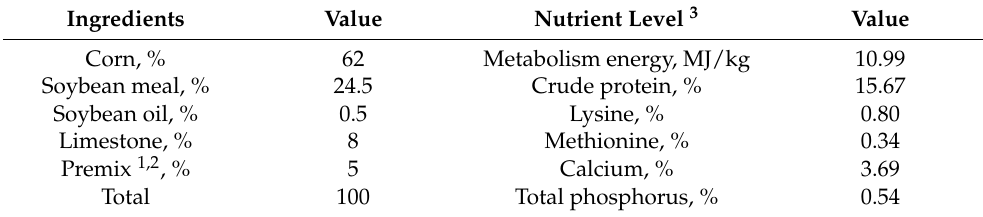
Table 1. Ingredient compositions and nutrient levels of basal diet for hens. Ingredients